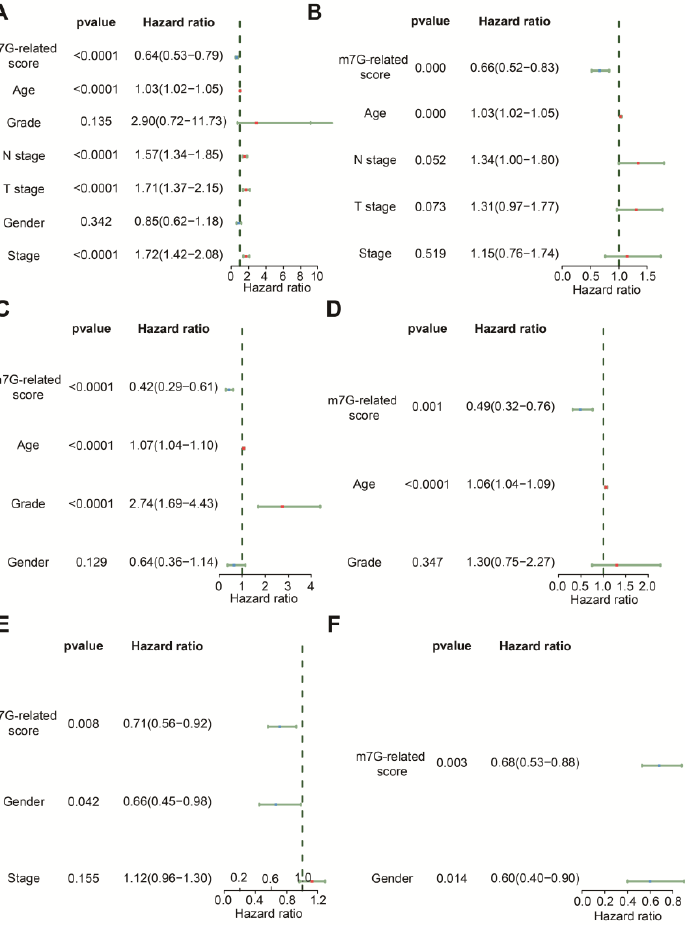
Figure 5. Comparison of other clinical features in prediction of OS. ( A ) The forest plot of univariate Cox regression analysis in the TCGA-BLCA dataset. ( B ) The forest plot of multivariate Cox regression analysis in the TCGA-BLCA dataset. ( C ) The forest plot of univariate Cox regression analysis in the GSE13507 dataset. ( D ) The forest plot of multivariate Cox regression analysis in the GSE13507 dataset. ( E ) The forest plot of univariate Cox regression analysis in the IMvigor210 cohort. ( F ) The forest plot of multivariate Cox regression analysis in the IMvigor210 cohort.